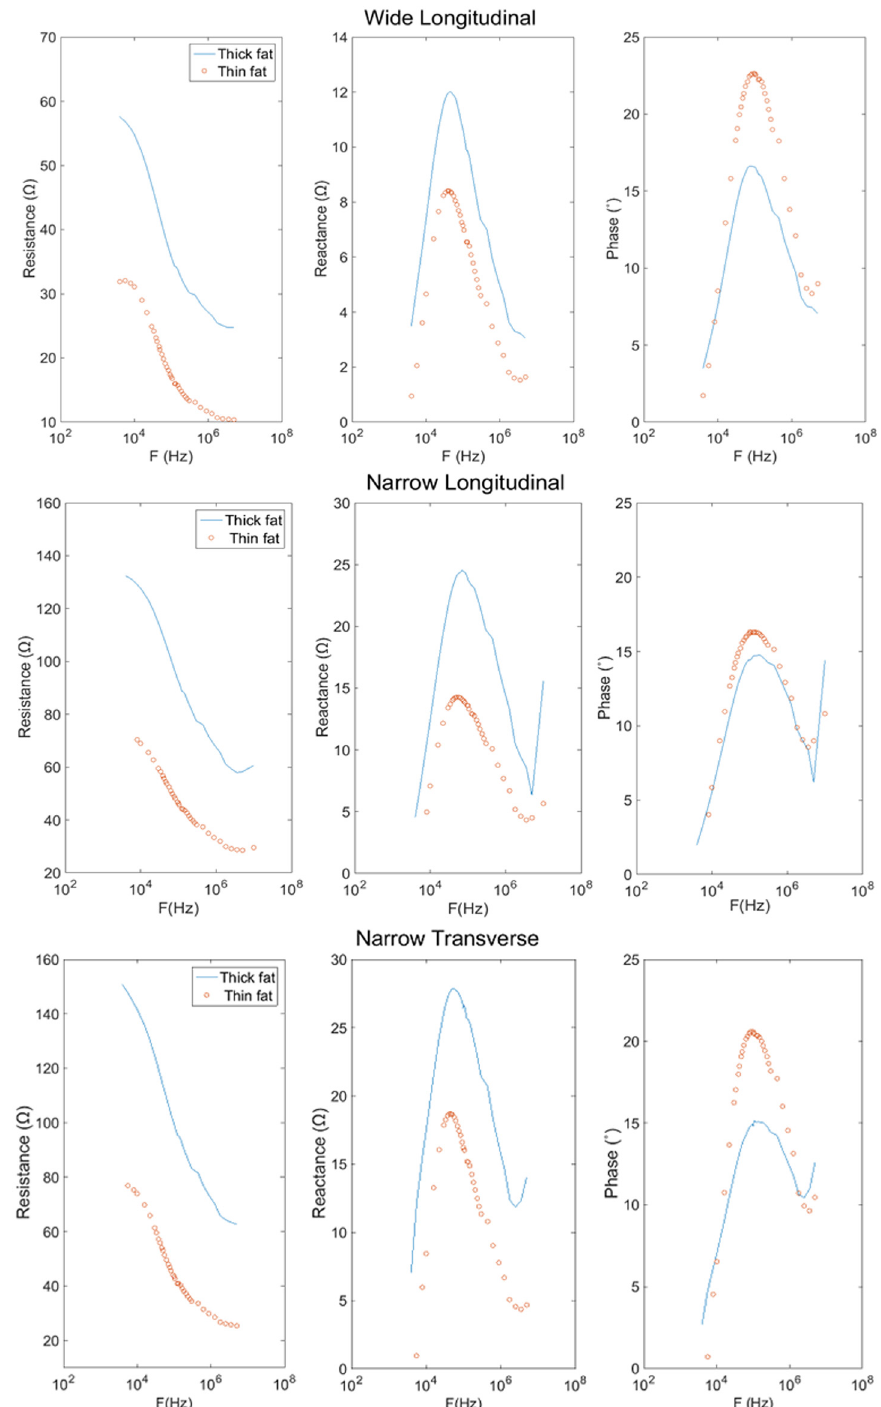
Fig 7. Resistance, reactance and phase vs. logarithm of frequency for biceps brachii of a 34 year old female (solid line) and a 35 year old male (dotted line) using different electrode configurations.